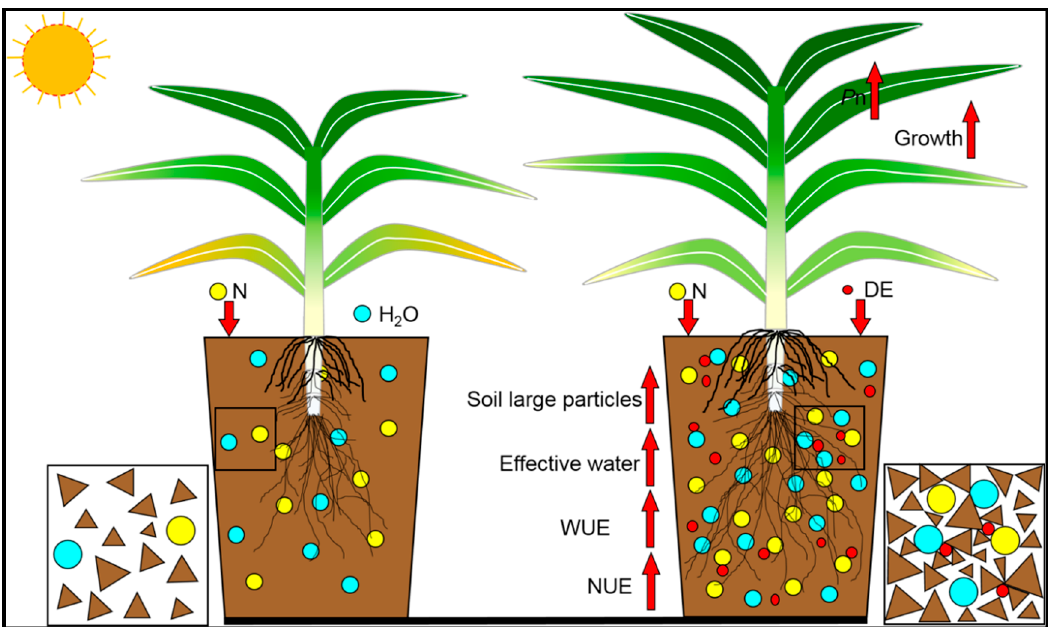
Figure 7. A schematic model of DewEco application on sandy soil quality. DewEco application could improve soil texture, decrease particle pore size, increase content of large particles, increase capacity for water retention and improve fertility, decrease soil pH and increase soil EC and nutrient contents, which together contribute to enhancing plant growth.